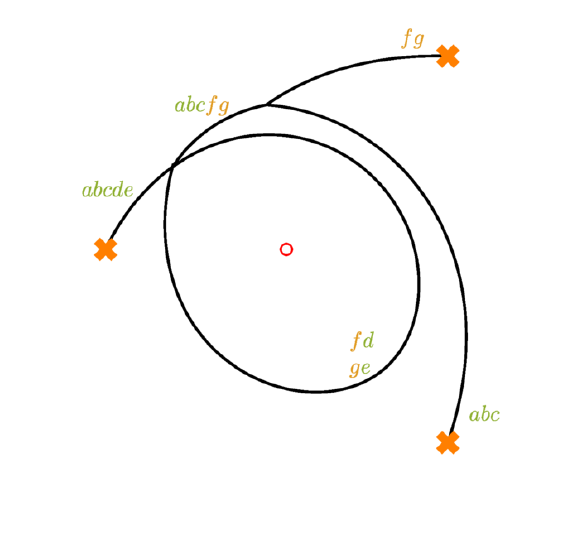
Figure 38. A (cid:12)nite web for dimension (2 ; 5) representation.